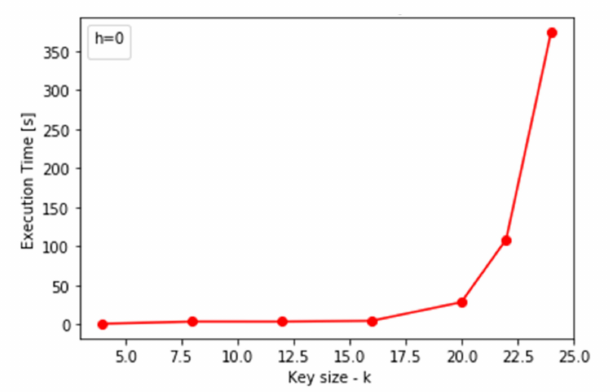
Figure 16. Execution time of the locking algorithm against h , increasing k when h = 0 causes exponential execution time increase in a program because there is a loop in implementation that iterates 2 k times and executes the body ( k h ) times. In the case of h = 0, the number of iterations causes the exponential execution time.